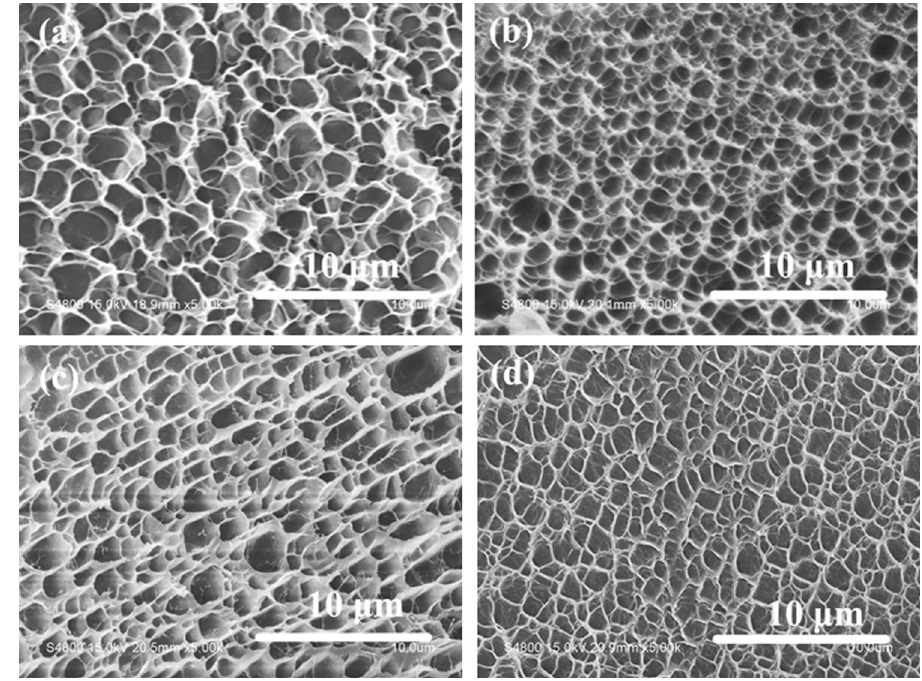
Figure 4: SEM images of BPSQ aerogels: ( a ) BTPB - 10 - 0, ( b ) BTPB - 15 - 0, ( c ) BTPB - 15 - 0.50, and ( d ) BTB - 15 -